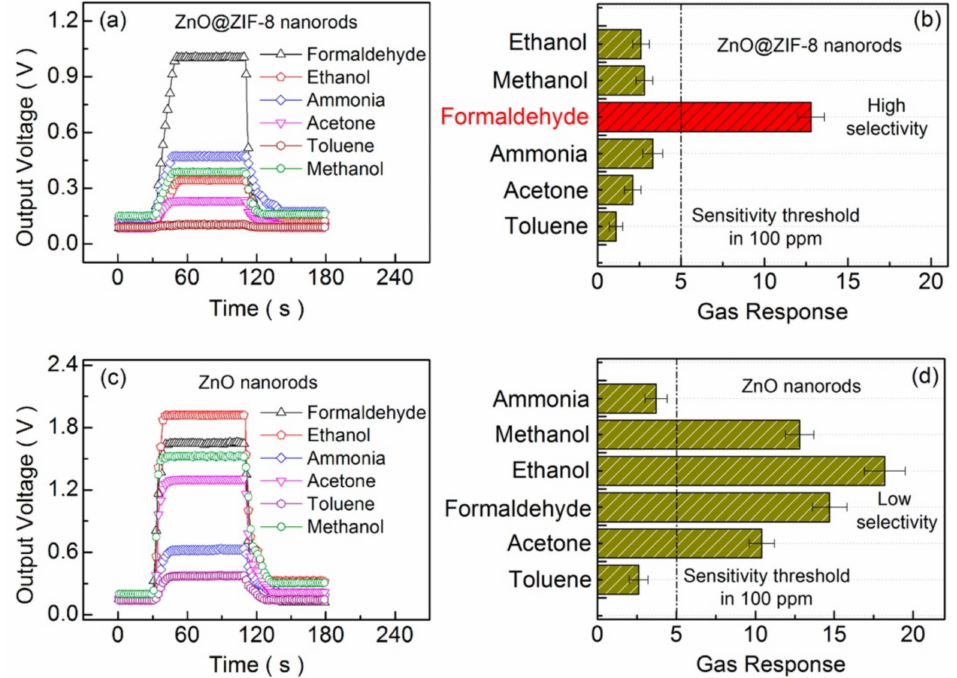
Figure 6. ( a , b ) Transient curves of the gas response and the selectivity of the ZnO@ZIF − 8 nanorods sensor to 100 ppm of various VOCs at 300 ◦ C, and ( c , d ) transient curves of gas sensing and the selectivity of the nanosensor to 100 ppm of various VOCs at 300 ◦ C. Reprinted with permission from [58]. Copyright American Chemical Society,